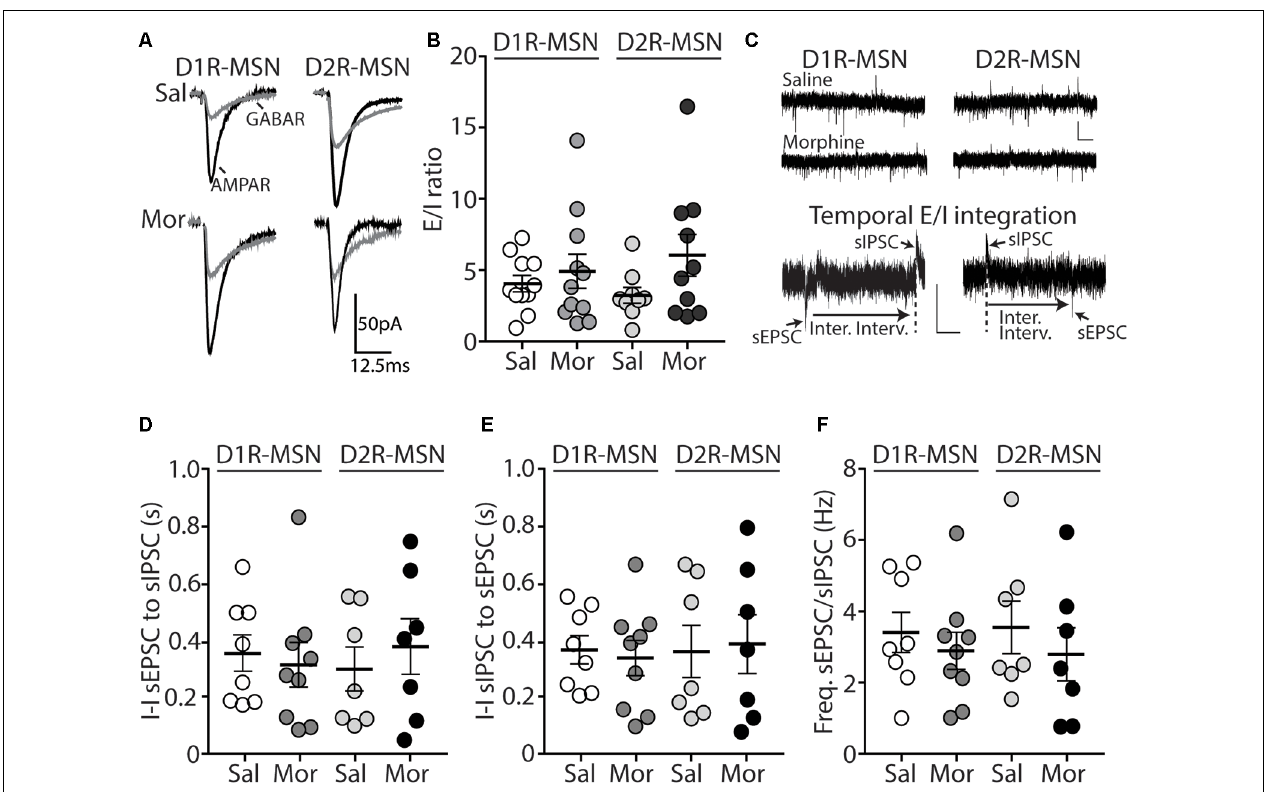
FIGURE 2 | Short-term abstinence from in vivo morphine treatment has no effect on the evoked excitatory/inhibitory (E/I) ratio and does not alter the temporal relationship between spontaneous EPSCs (sEPSCs) and spontaneous inhibitory postsynaptic currents (sIPSCs) on D1R- or D2R-MSNs in the nucleus accumbens shell. (A) Representative traces showing evoked AMPA receptor (AMPAR)- and GABA receptor (GABAR)-mediated currents on D1R- or D2R-MSNs 24 h following repeated saline or morphine treatments. Neurons were held at − 70 mV. (B) Summary graph showing the E/I ratio of evoked currents on D1R- or D2R-MSNs 24 h following repeated saline (sal) or morphine (mor; 10 mg/kg, i.p.) treatments. There were no significant differences between groups in male or female mice. (C) Representative traces showing spontaneous EPSCs (inward current) and IPSCs (outward current) when D1R- or D2R MSNs were held at − 30 mV 24 h following in vivo morphine treatment. Scale bars: 20 pA, 0.5 s (Lower). Electrophysiological recordings in whole-cell patch-clamp configuration showing the inter-event intervals (inter. interv.) of sEPSCs to sIPSCs (left) or sIPSCs to sEPSCs (right) in a MSN held at − 30 mV. Scale bars: 20 pA, 0.125 s. (D) Summary graph showing no significant changes in the inter-event interval (I-I) between sEPSCs and sIPSCs on D1R- or D2R-MSNs 24 following repeated saline or morphine administration in male mice. (E) Summary graph showing no significant changes in the inter-event interval (I-I) between sIPSCs and sEPSCs on D1R- or D2R-MSNs 24 following repeated saline or morphine administration in male mice. (F) Summary graph showing that morphine exposure had no effect on the frequency ratio of sEPSC to sIPSC events within D1R- or D2R-MSNs in male mice.